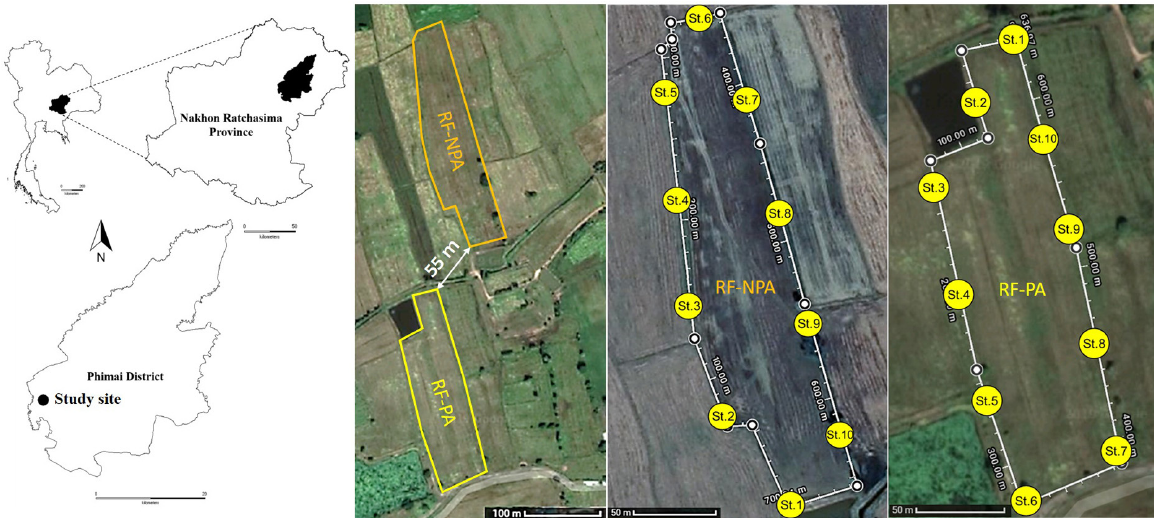
Figure 1. Map of the study sites in Phimai District, Nakhon Ratchasima Province, showing the 10 sampling stations in RF-NPA and RF-PA.